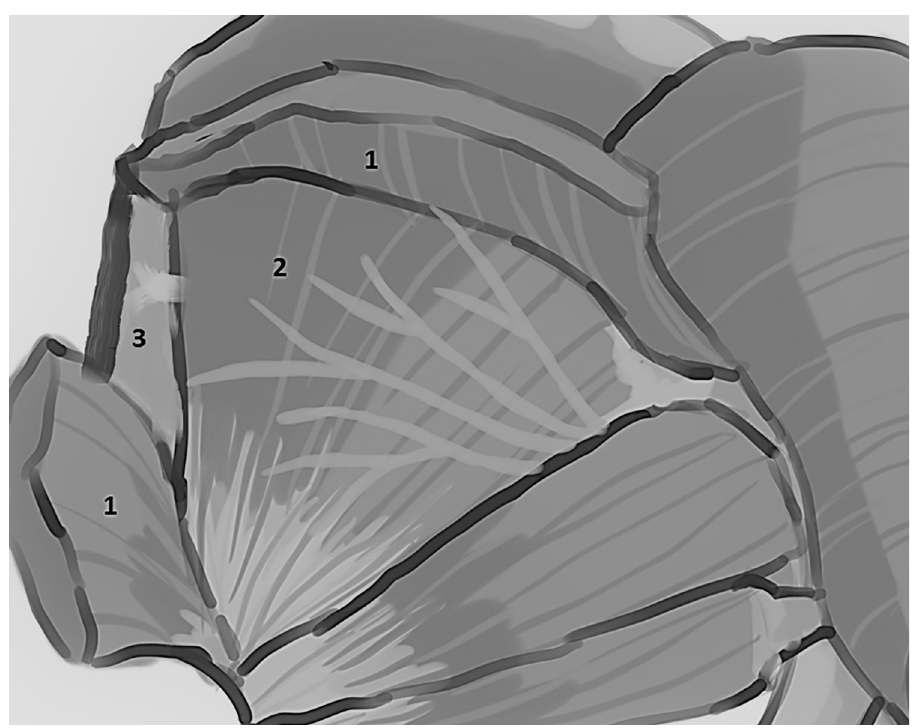
Fig 14. Superior gluteal nerve, bushy type–anatomical diagram of the nerve path (thanks to Julia Derkowska), 1–gluteus medius muscle, 2–gluteus minimus muscle, 3–tensor fasciae latae muscle.